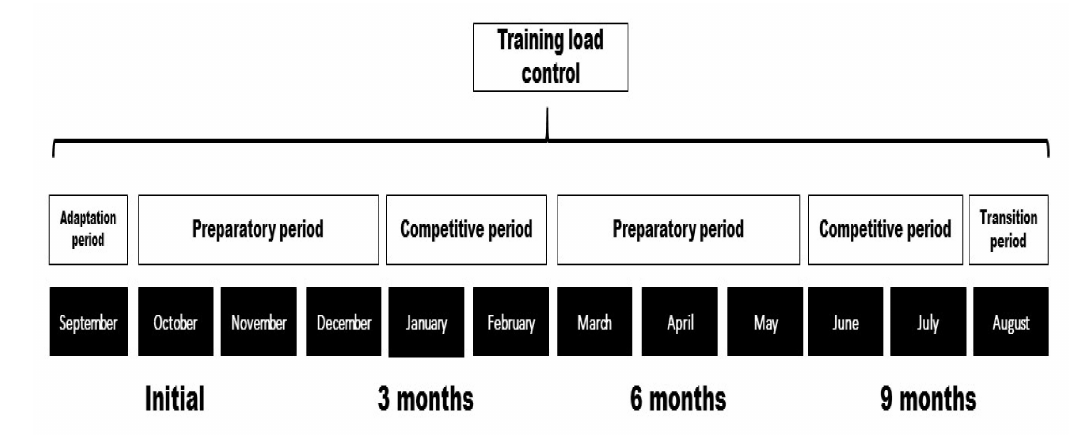
Figure 1. Periodisation during the season. Table 1. Training loads in the runners during the season. Training